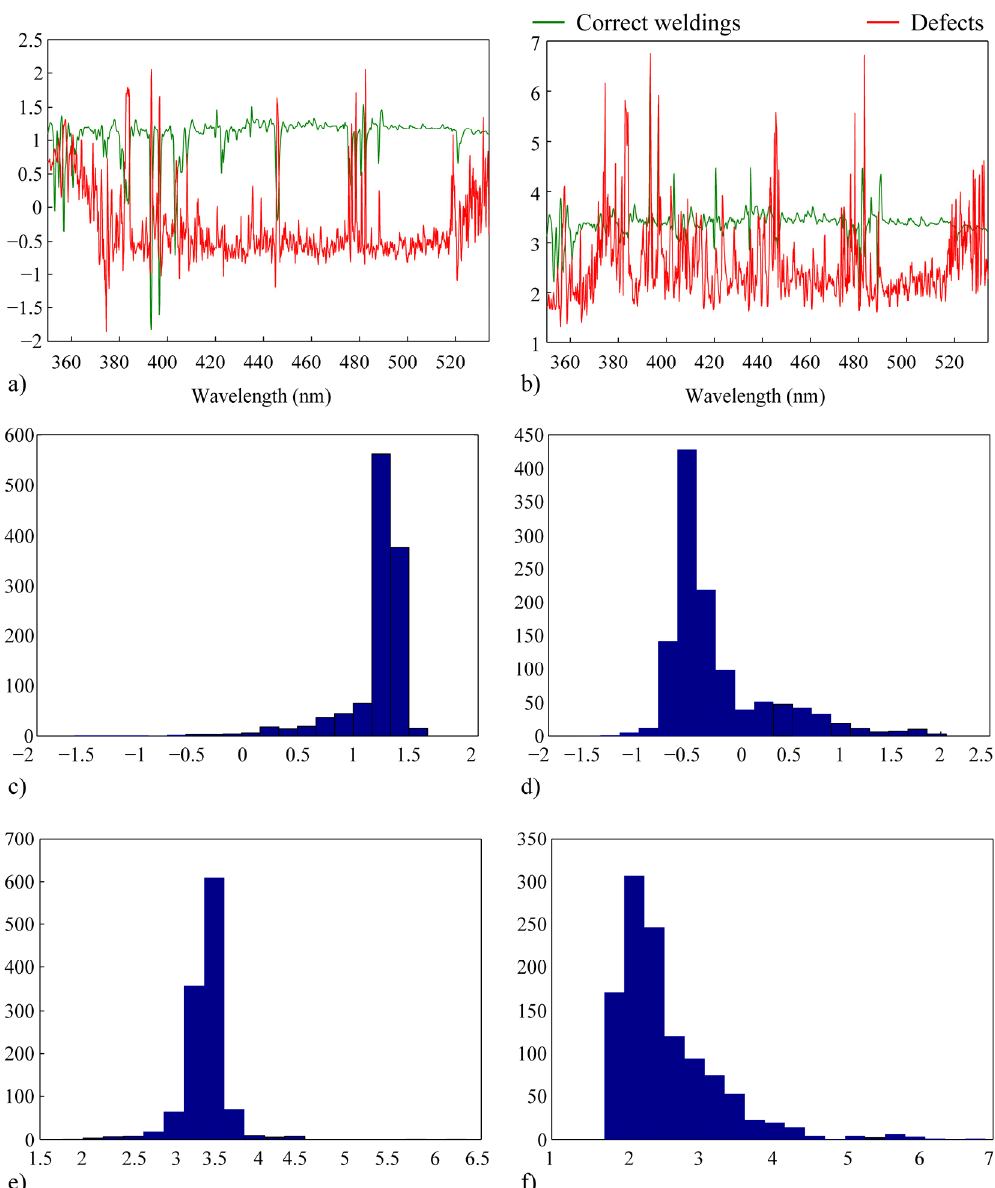
Figure 6. Modelling of the data distribution function of the classes: a) and b) skewness and kurtosis values per class and wavelength; c) histogram of skewness values of correct weldings d) histogram of skewness values of defects; e) and f) idem for kurtosis